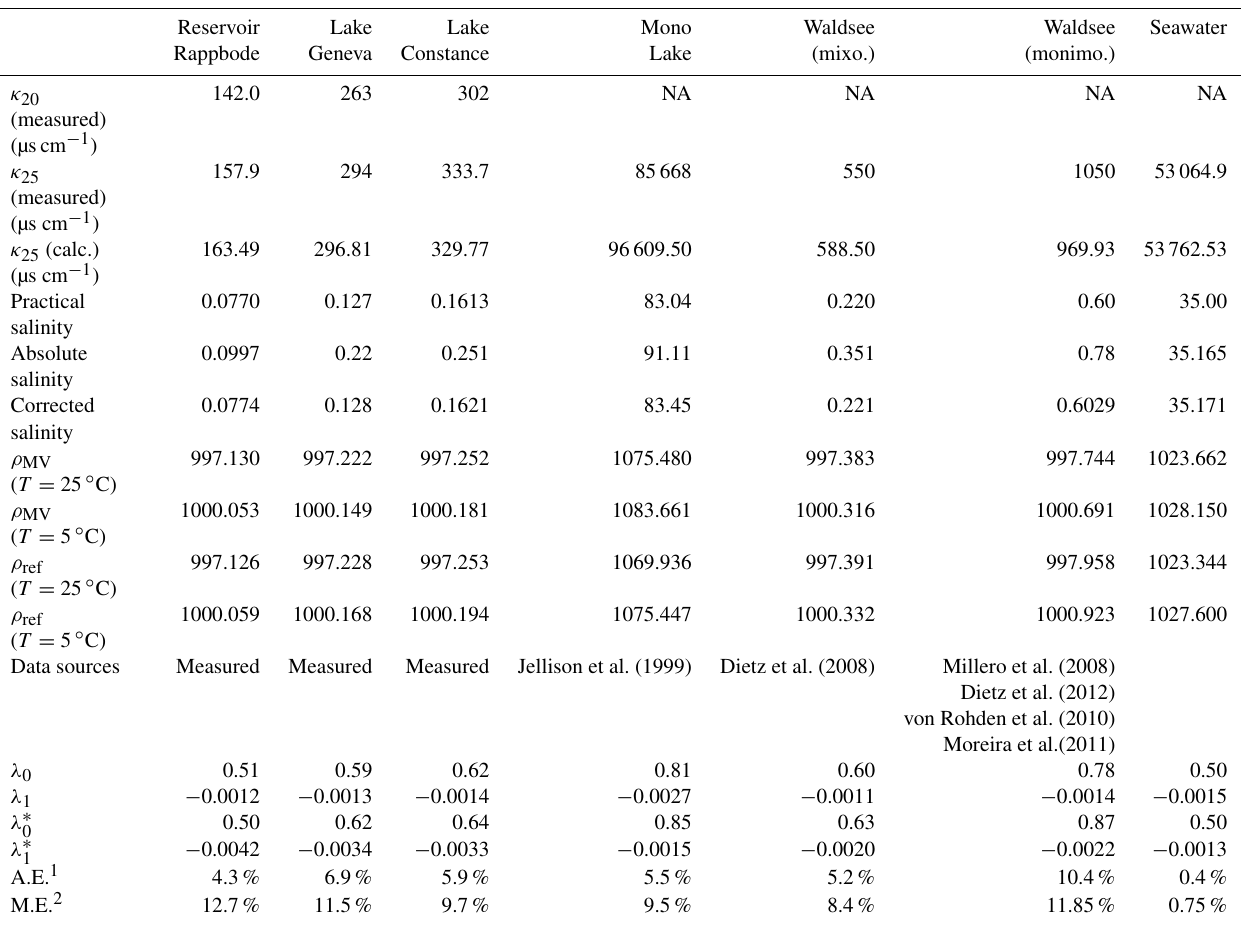
Table 2. Summary of the calculated values for obtaining RHOMV_LAMBDA coefficients. Lambdas and references: λ 0 and λ 1 represent the lambda values obtained using the chemical composition of Table 1 to calculate density and conductivity at 5 and 25 ◦ C, while λ ∗ represent the lambda values obtained from a linear regression of the density reference. λ 0 and λ ∗ and λ ∗ are expressed in kg cm m − 3 mS − 1 K − 1 . Density values are expressed in kgm − 3 . Corrected salinity shows the values of Practical 1 salinity corrected by a factor of 1.00488 for the Chen and Millero (1986) method. For more details, see